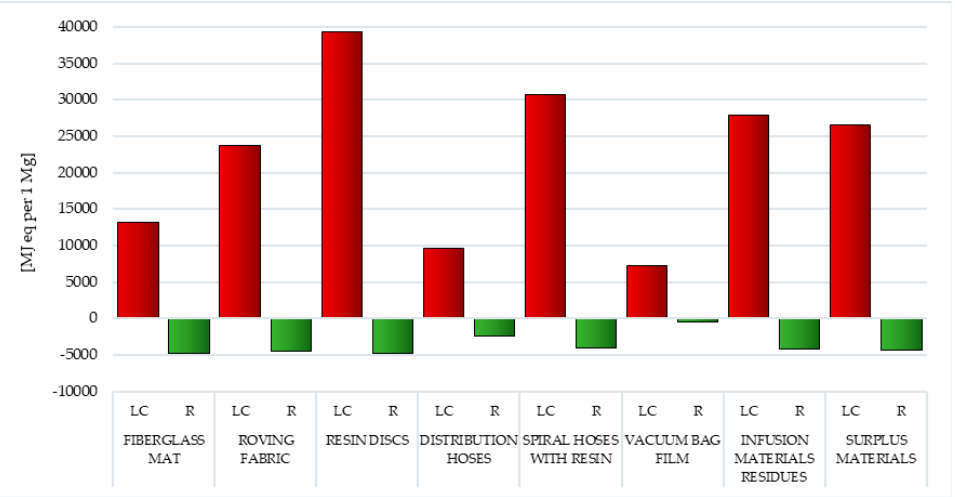
Figure 16. Characterization results of environmental consequences for processes related to energy